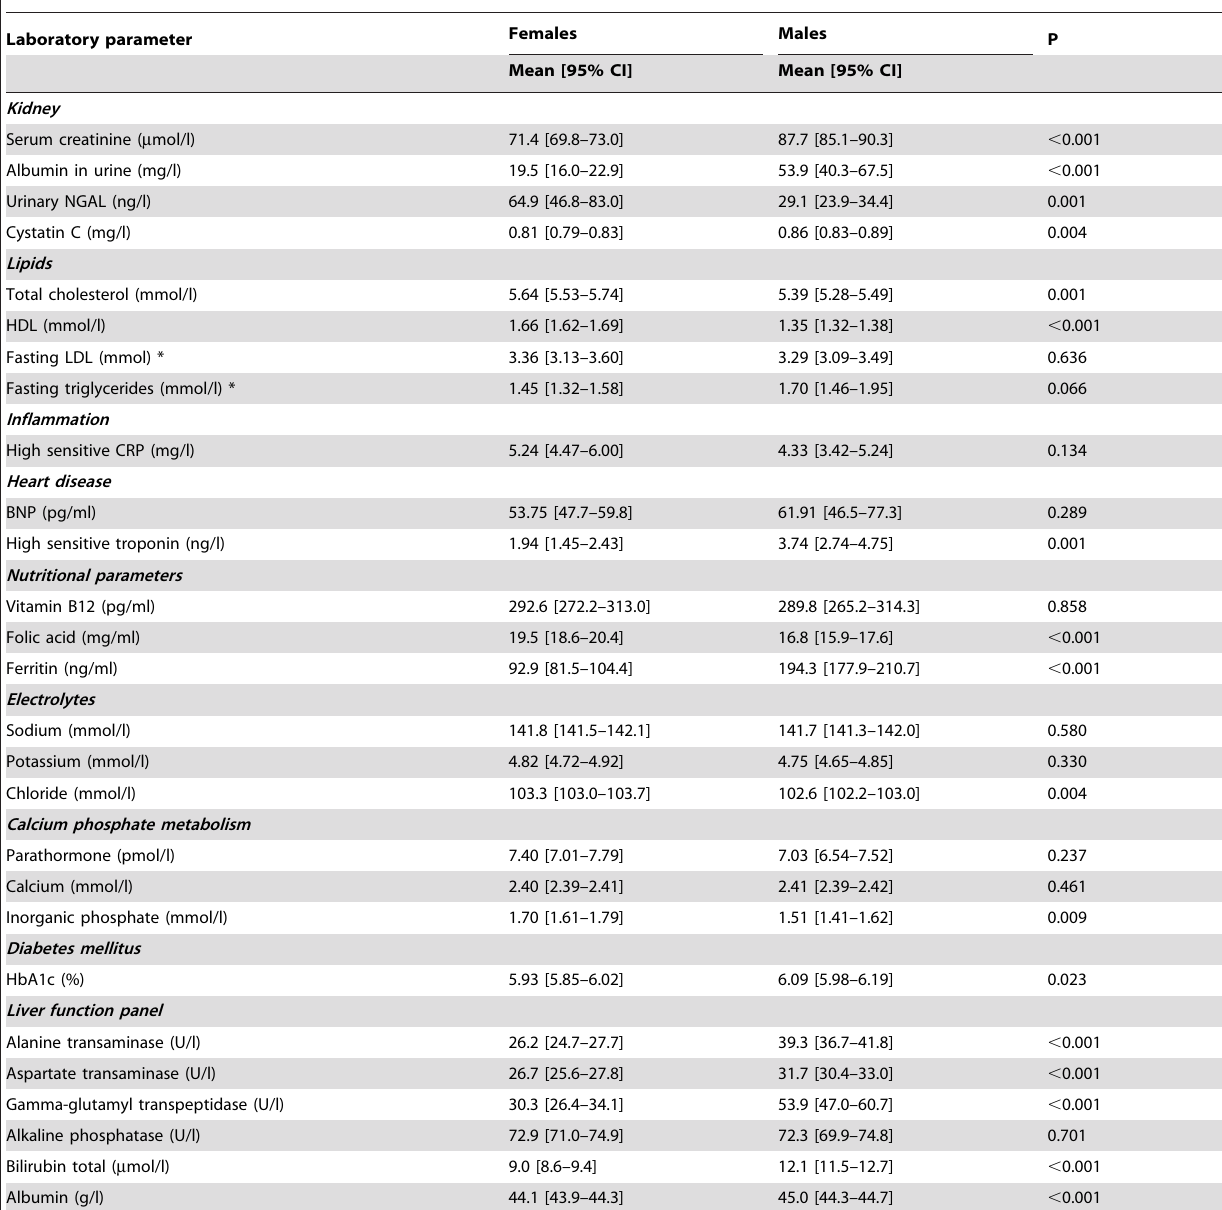
Table 2. Laboratory parameters in the recruited patient